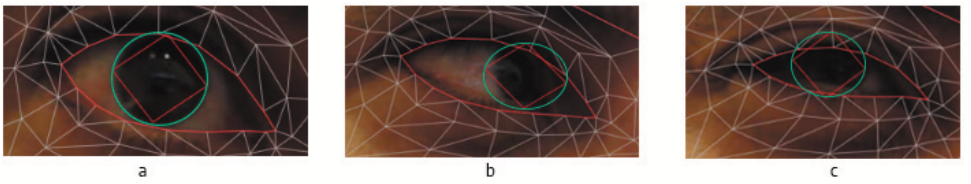
Figure 5. Examples of iris detection with our proposed method: ( a ) iris in the center, ( b ) iris near eyled tip, ( c ) iris with eye blinking.